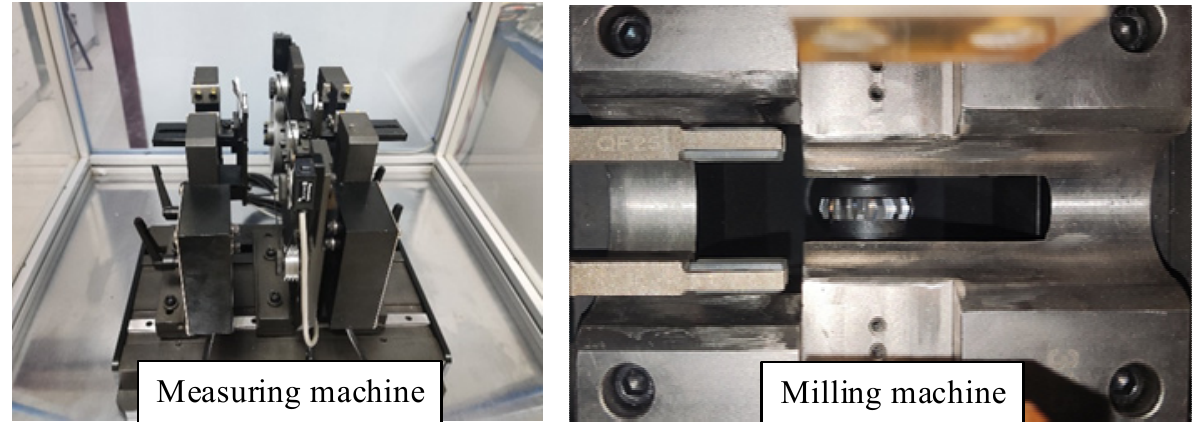
Figure 10. Experimental machines for measuring and milling unbalance vector.